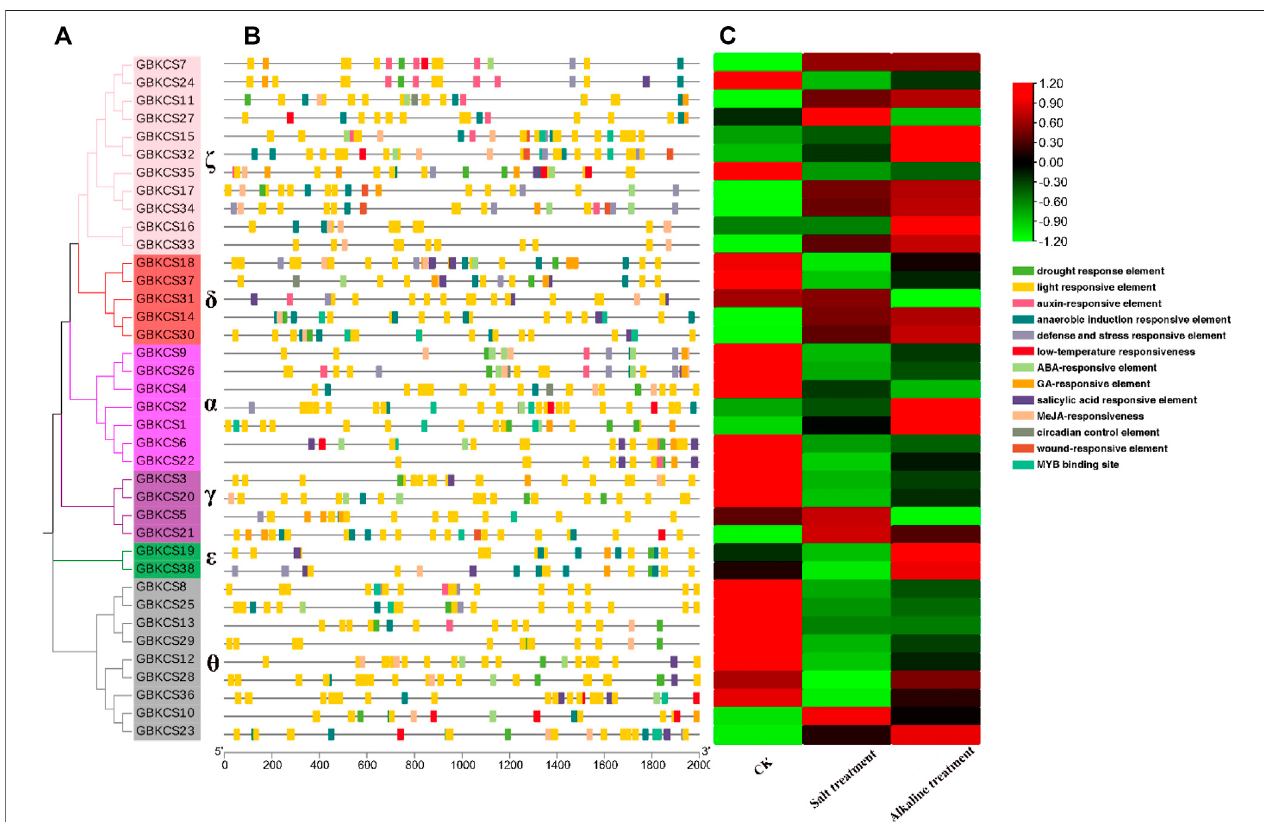
FIGURE 5 | Analysis of promoters and differentially expressed genes of GBKCSs family. (A) Phylogenetic tree of GBKCSs ; (B) Cis-elements in promoters of GBKCS genes; (C) Differentially expressed genes of GBKCS genes under salt and alkaline stress. (The control sample was designated as CK. The Na 2 CO 3 processed sample designated as Alkaline, and the NaCl processed sample designated as